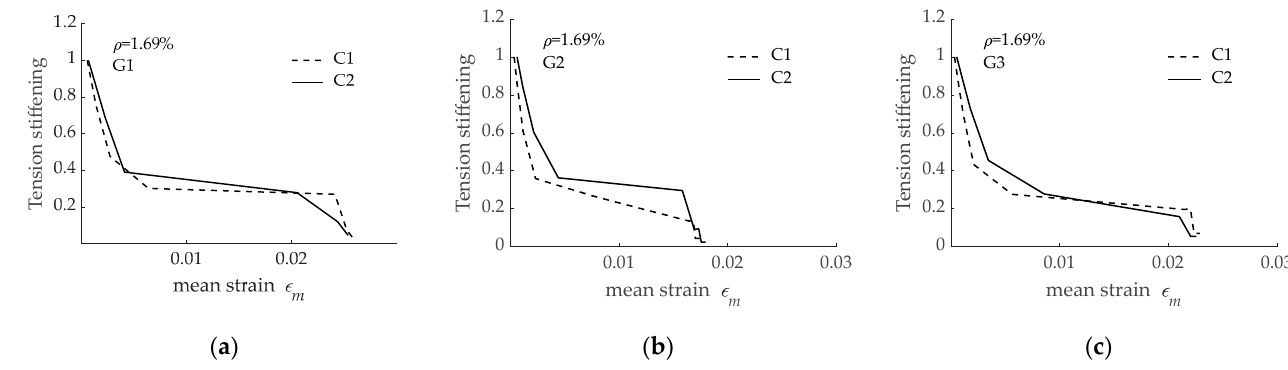
Figure 13. Effect of concrete compressive strength on tension stiffening effect for RC tensile elements ( ρ = 1.69%) reinforced with: ( a ) G1 bar; ( b ) G2 bar; ( c ) G3 bar.